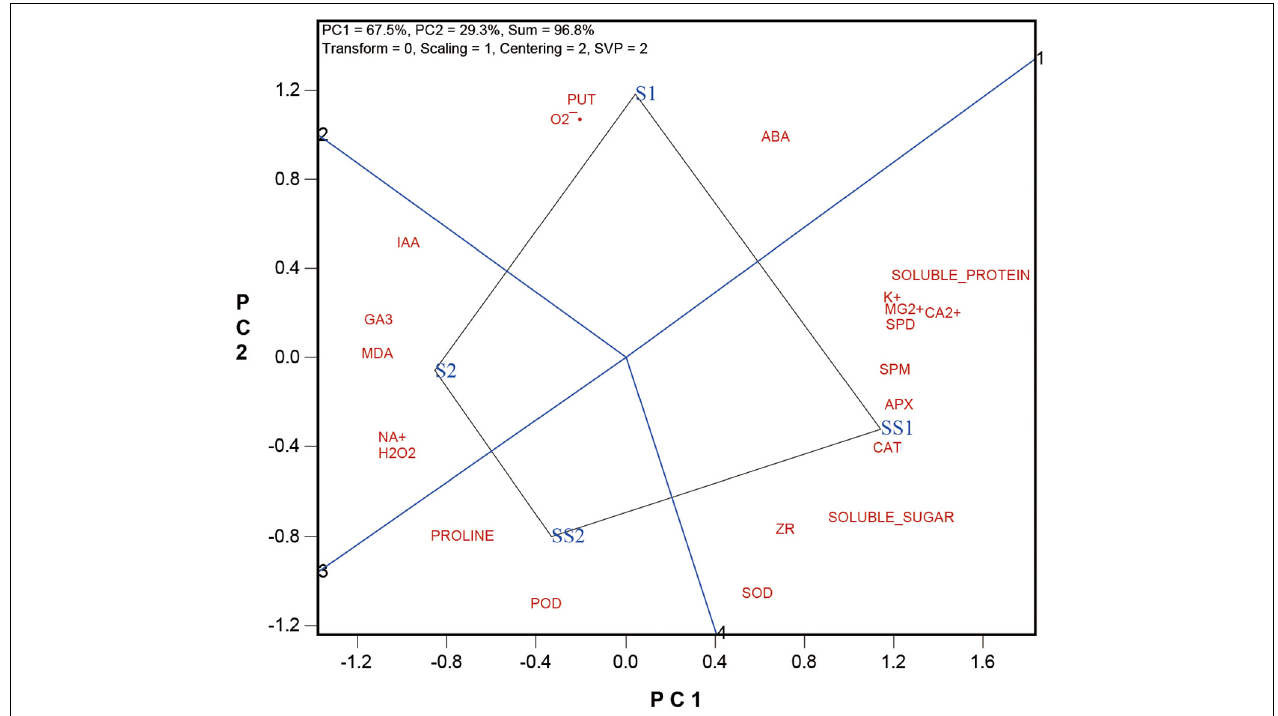
FIGURE 2 | The which-won-where view of the GGE biplot to show which trait performed bets in which